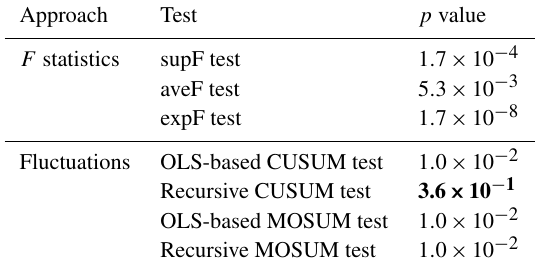
Table A2. Tests for the presence of significant structural changes in C i . The p value indicates the probability that the null hypothesis (i.e., there are no significant change points) should be maintained. All tests, except that highlighted in bold, indicate the presence of significant structural changes in C i with a confidence level higher than 95%.